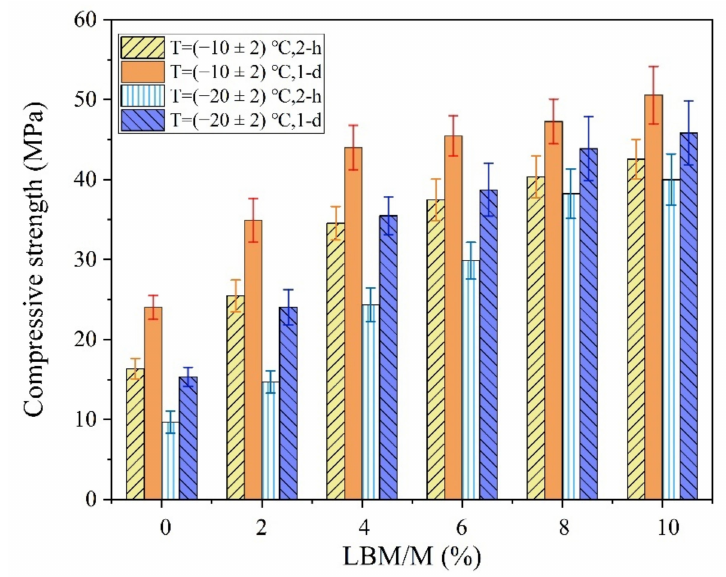
Figure 7. The influences of LBM / M ratios on the early strength of the